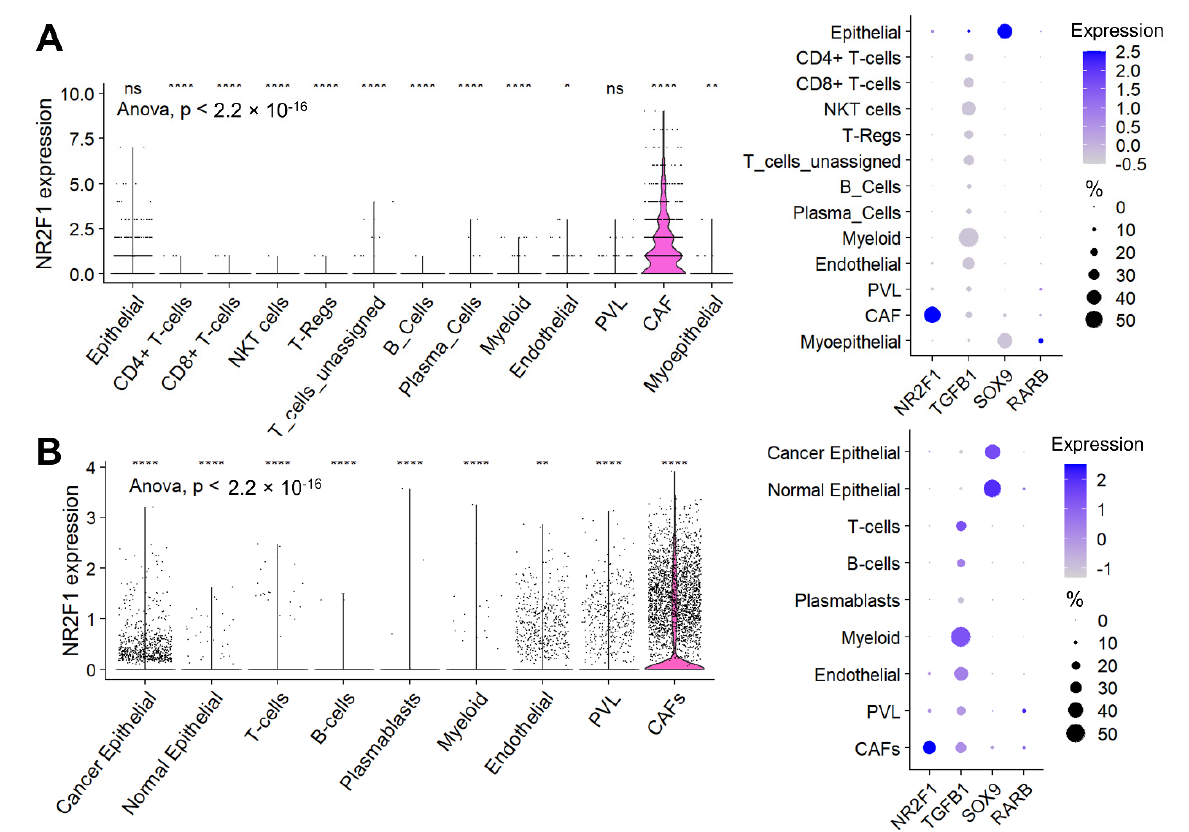
Figure 6. Expression of NR2F1 and dormancy − related genes by cell types. ( A ) The violin plot on the left shows NR2F1 expression of single-cell Cohort 1 by cell type: epithelial cells, CD4+ T-cells, CD8+ T-cells, natural killer T-cells (NKT), regulatory T-cells (T-reg), unassigned T-cells, B-cells, plasma cells, myeloid cells, endothelial cells, perivascular like cells (PVL), cancer-associated fibroblast (CAFs), and myoepithelial cells. One dot represents one cell. After multi-group comparison, baseline NR2F1 expression and expression in each cell type were compared in two groups by one-way ANOVA test. The dot plot on the right shows NR2F1 , TGFB1 , SOX9 , and RARB expression by cell type in the single-cell Cohort 1. The size of each dot indicates the number of cells, and the purple intensity indicates the expression level. ( B ) The violin plot on the left shows NR2F1 expression of single-cell Cohort 2 by cell type: cancer epithelial cells, normal epithelial cells, T cells, B cells, plasmablasts, myeloid cells, endothelial cells, PVL, and CAFs. The dot plot on the right shows NR2F1 , TGFB1 , SOX9 , and RARB expression by cell type in the single-cell Cohort 2. Symbols in the figure are as follows: ns, p > 0.05; *, p ≤ 0.05; **, p ≤ 0.01; ****, p ≤ 0.0001.